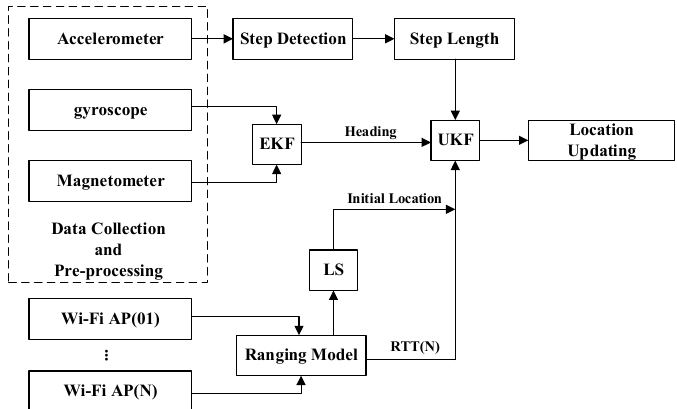
Figure 6. Framework of the Wi-Fi FTM and multiple sensors (DRWM)s algorithm.